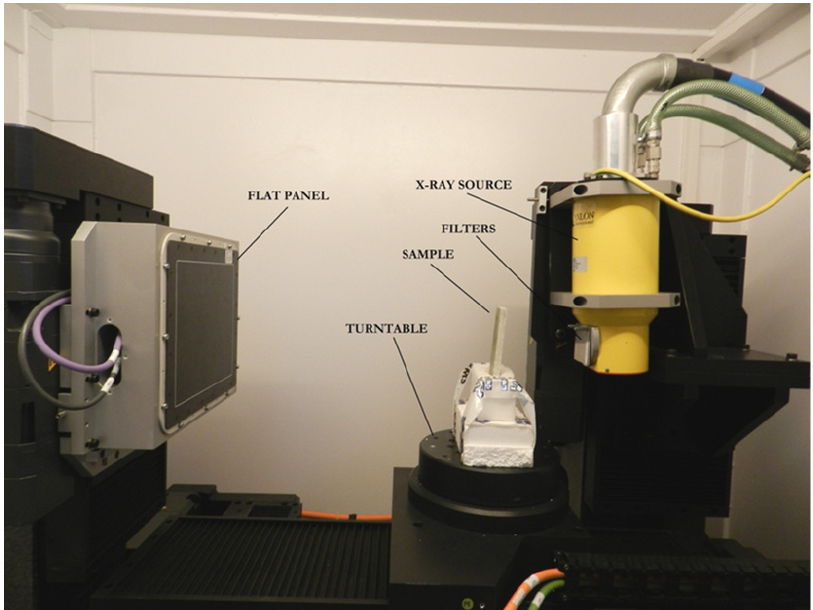
Figure 3: Y.CT Vario cone-beam X-ray tomography